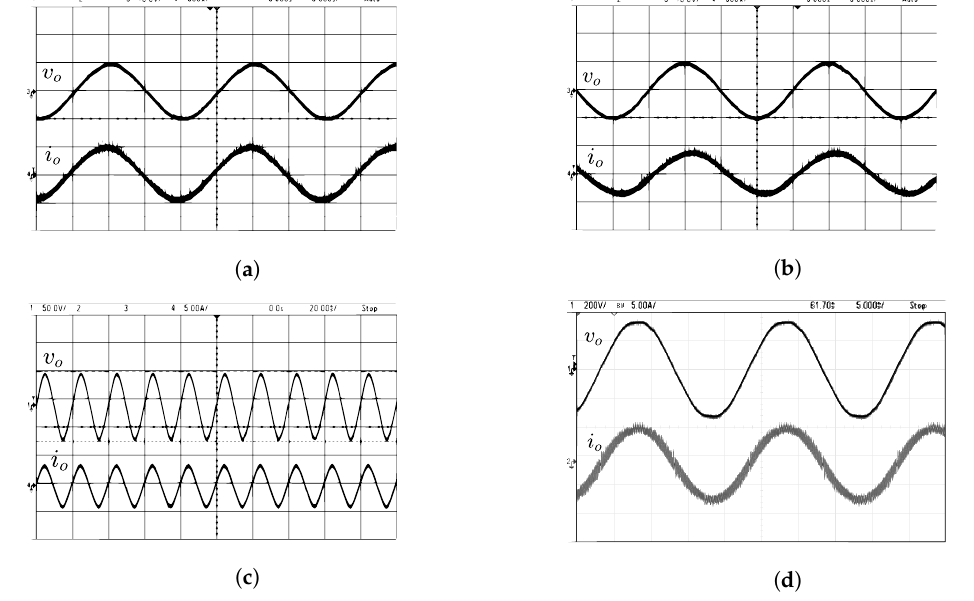
Figure 22. Experimental results under steady state ( a ) top trace: load voltage v o (10 V/div), bottom trace: load current i o (500 mA/div) for R load = 10 Ω , 10 W; ( b ) top trace: load voltage v o (10 V/div), bottom trace: load current i o (500 mA/div) for R-L load, R = 10 Ω , 10 W, L = 12 mH; ( c ) top trace: load voltage v o (50 V/div), bottom trace: load current i o (5 A/div) for 100 W lamp load; ( d ) top trace: load voltage v o (200 V/div), bottom trace: load current i o (5 A/div) for 1000 W